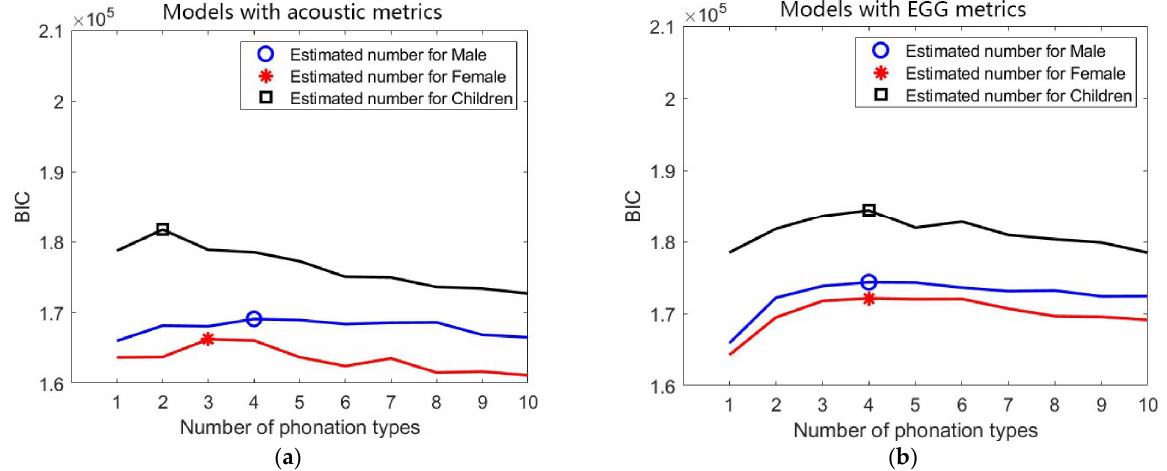
Figure 5. BIC values for models with ( a ) acoustic metrics only and ( b ) EGG metrics only.